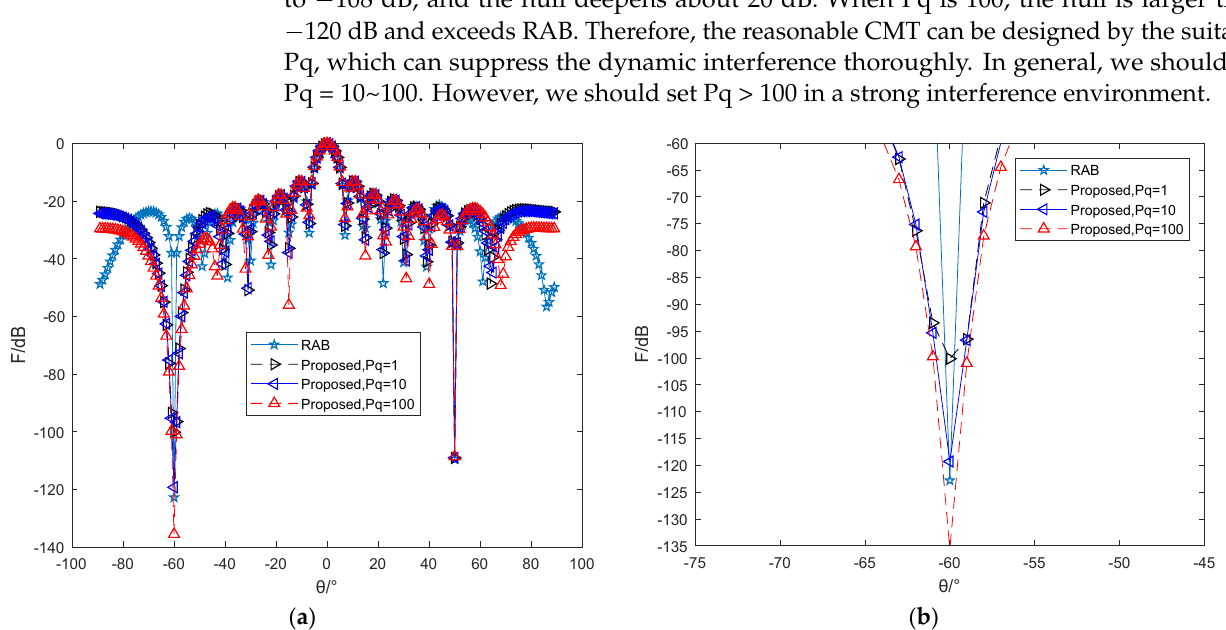
Figure 3. Comparison of null depth: ( a ) overall pattern, ( b ) local enlarged drawing.